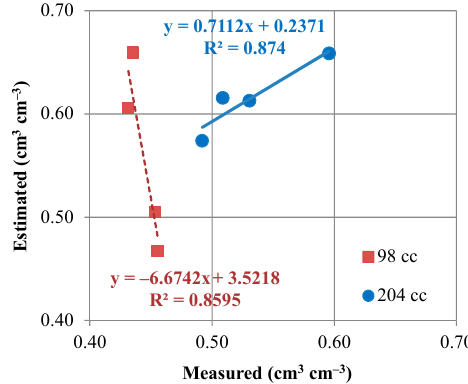
Figure 3. Correlation between mean values of measured and estimated saturated soil water contents, obtained using soil sampler of 98 and 204 cm 3 , under CT and NT of Foggia and Matera sites. The e ff ect of sampled soil volume on estimated SPQ indicators (i.e., BD, MAC por , AC, and